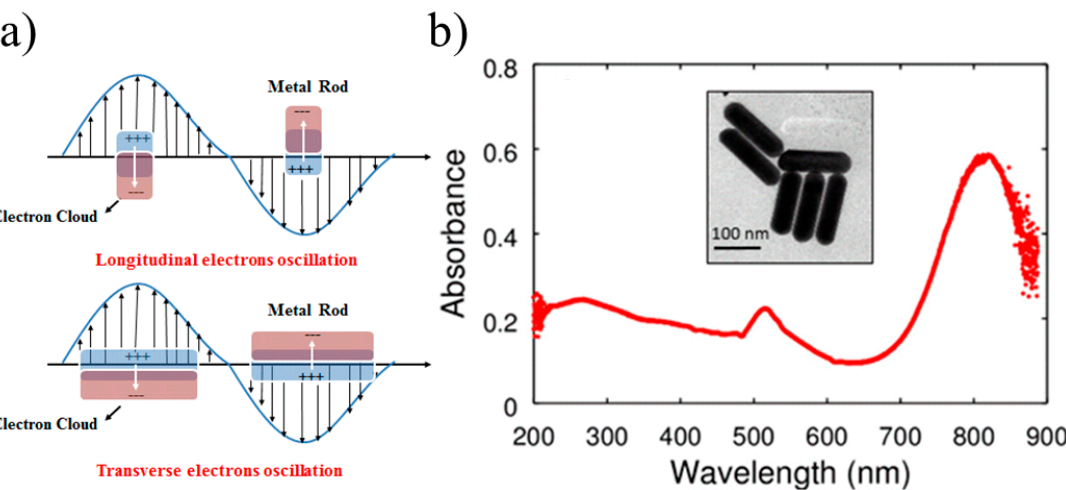
Figure 2. ( a ) Two typical forms of localized surface plasmon resonance (longitudinal and transverse electron oscillations) of gold NRs. Adapted from Ref. [41]; ( b ) absorption spectra of gold NRs [42].